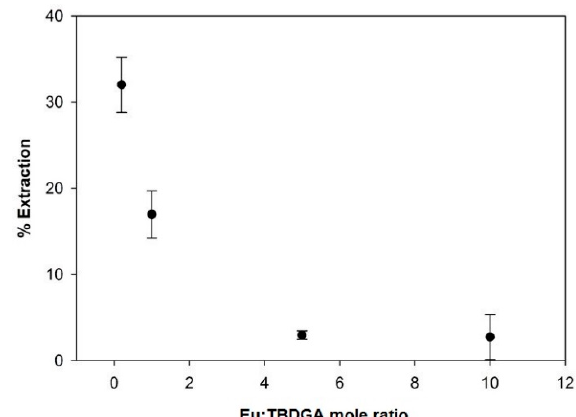
Figure 8. The percent extraction Eu from 8 M HCl with TBDGA in CO 2( l ) modified with 2 mol% 1-octanol at 34.5 MPa and 23 °C where the starting Eu concentration in the HCl phase is varied from 1000 to 50,000 mg/kg.